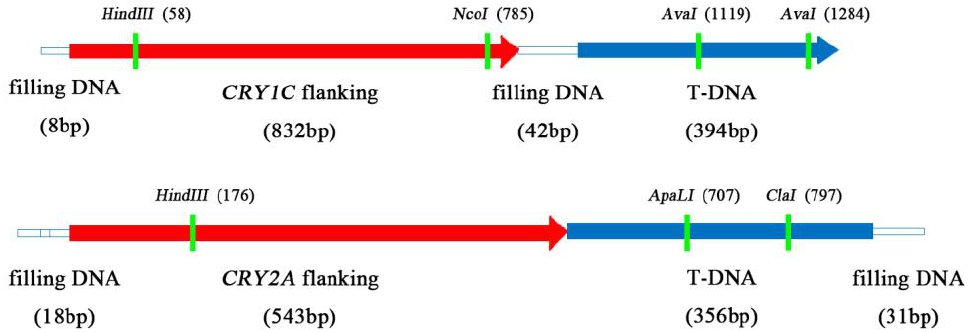
Figure 2. Schematic map of flanking sequences of CRY1C and CRY2A insertion sites.